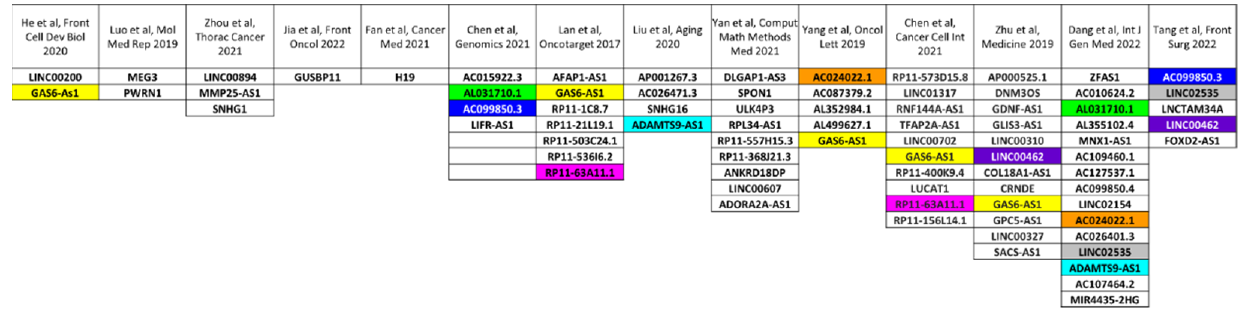
Figure 1. Prognostic lncRNA in pRCC patients, derived from refs [134,136,138–140,156–159,162,164,169,182,183].